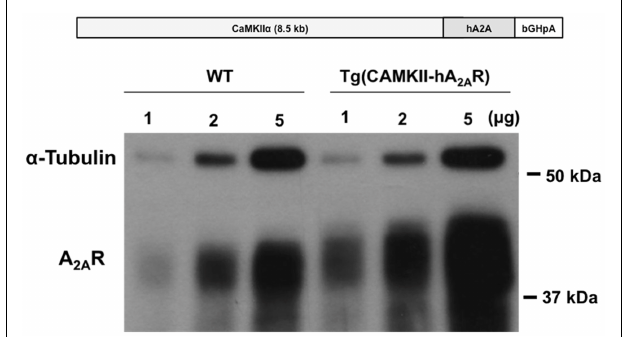
FIGURE 1 | Neuronal overexpression of adenosineA2A receptor (A 2A R) inTg(CaMII-hA2AR) rats . A 2A R overexpression in the striatum of Tg(CaMKII-hA2AR) rats compared toWT animals was confirmed by western